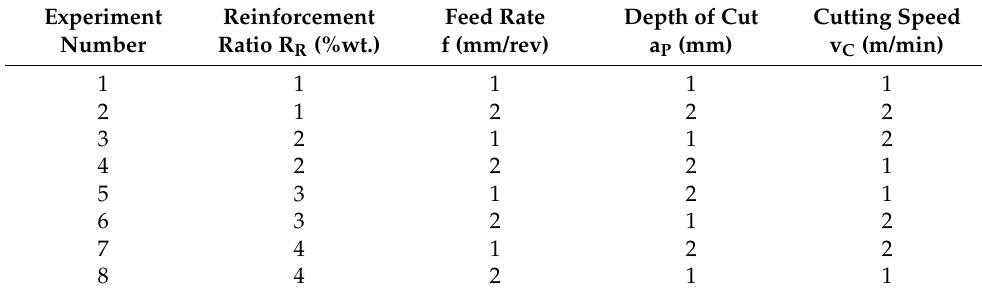
Table 2. Experimental design according to Taguchi’s L 8